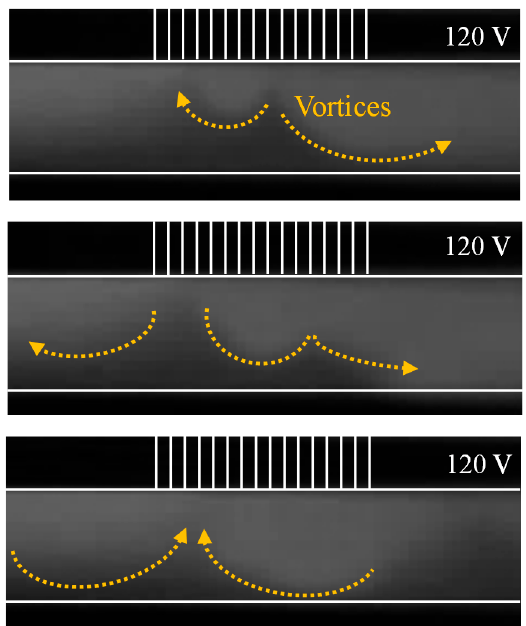
Figure 2. Images of vortex generation near the micro/nanochannel interface.